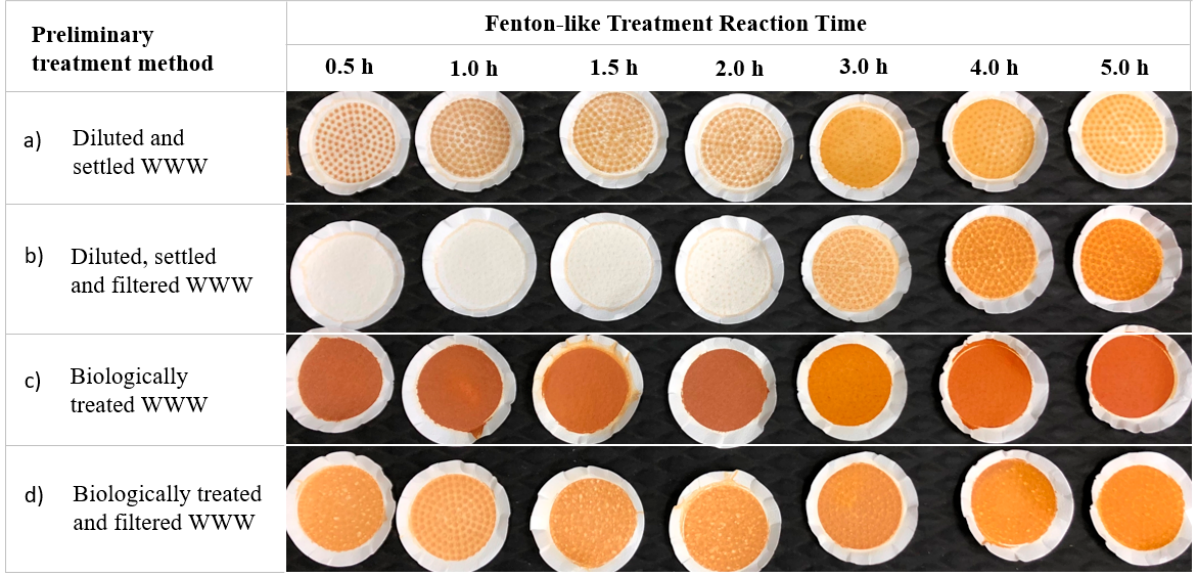
Figure 7. Residue left on 0.45 micron glass filter papers after filtering 25 mL of sample collected, quenched, and pH adjusted to >9 at various reaction times during Fenton-like treatment of WWW samples at H 2 O 2 2500 mg/L and Fe 3+ 325 mg/L that had undergone first-stage pre-treatment consisting of ( a ) dilution and settling, ( b ) dilution and settling followed by filtration, ( c ) biological treatment, and ( d ) biological treatment followed by filtration.